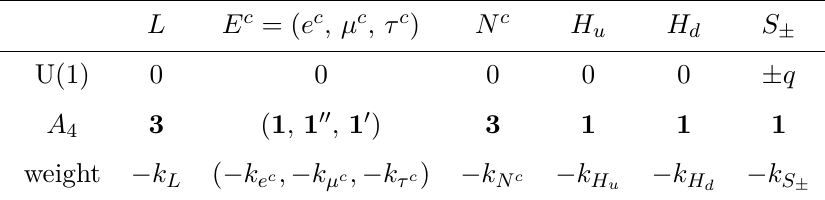
Table 1 . Field contents and their representations and modular